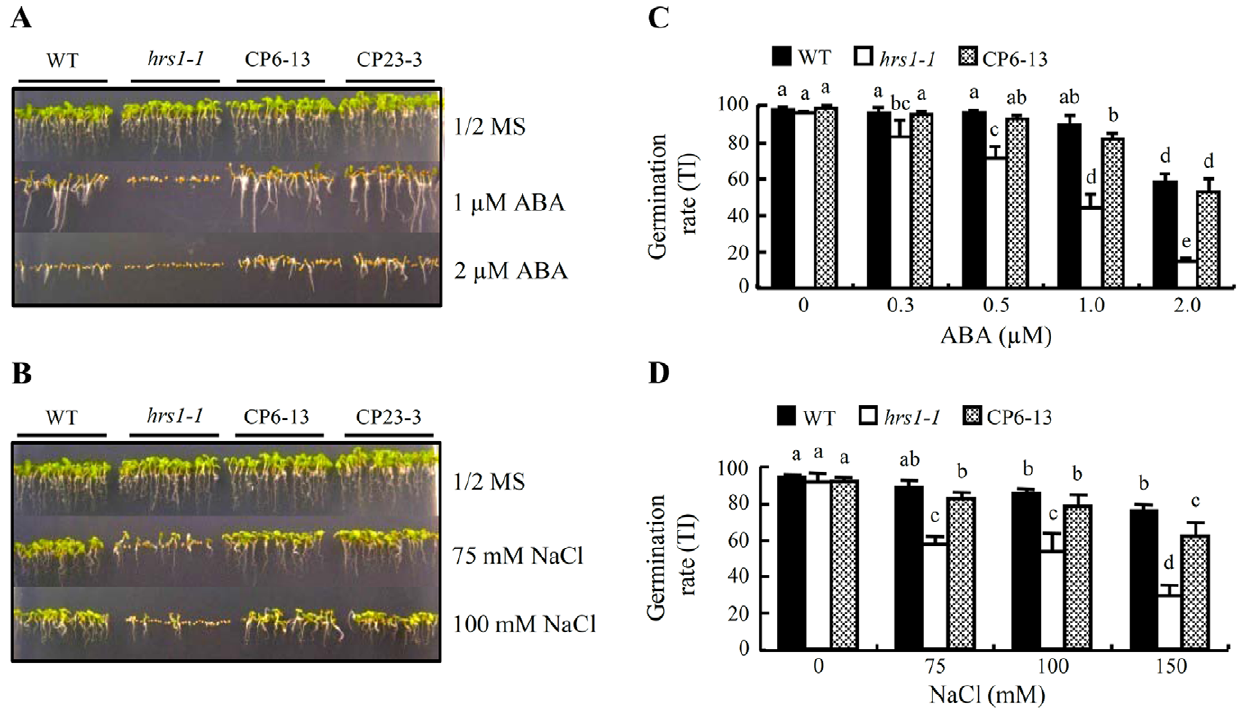
Figure 2. Effects of different concentrations of exogenous abscisic acid and NaCl on hrs1-1 germination. (A, B) The more severe delay of hrs1-1 germination, as compared to that of WT control and two CP lines (CP6-13 and CP23-3), conferred by increasing concentrations of abscisic acid (ABA) or NaCl added to the media. The data shown were recorded after 4 days of germination at 23 u C, and are representative of five separate assays. (C, D) Comparisons of the germination rates among WT control, hrs1-1 and CP line (CP6-13) on the media with the indicated concentrations of ABA or NaCl. Each germination rate value (TI, mean 6 SD) was calculated using the measurements from triplicate samples after 6 days of germination at 23 u C. The higher the value, the more rapid the germination proceeds. The data presented are all representative of three independent experiments, with the additional CP lines (CP19-1 and CP23-3) performing similarly as CP6-13 during the experiments. The means are labeled by different letters or letter combinations according to multiple statistical comparisons, and those labeled by one or more identical letters do not differ significantly from each other ( P # 0.05).